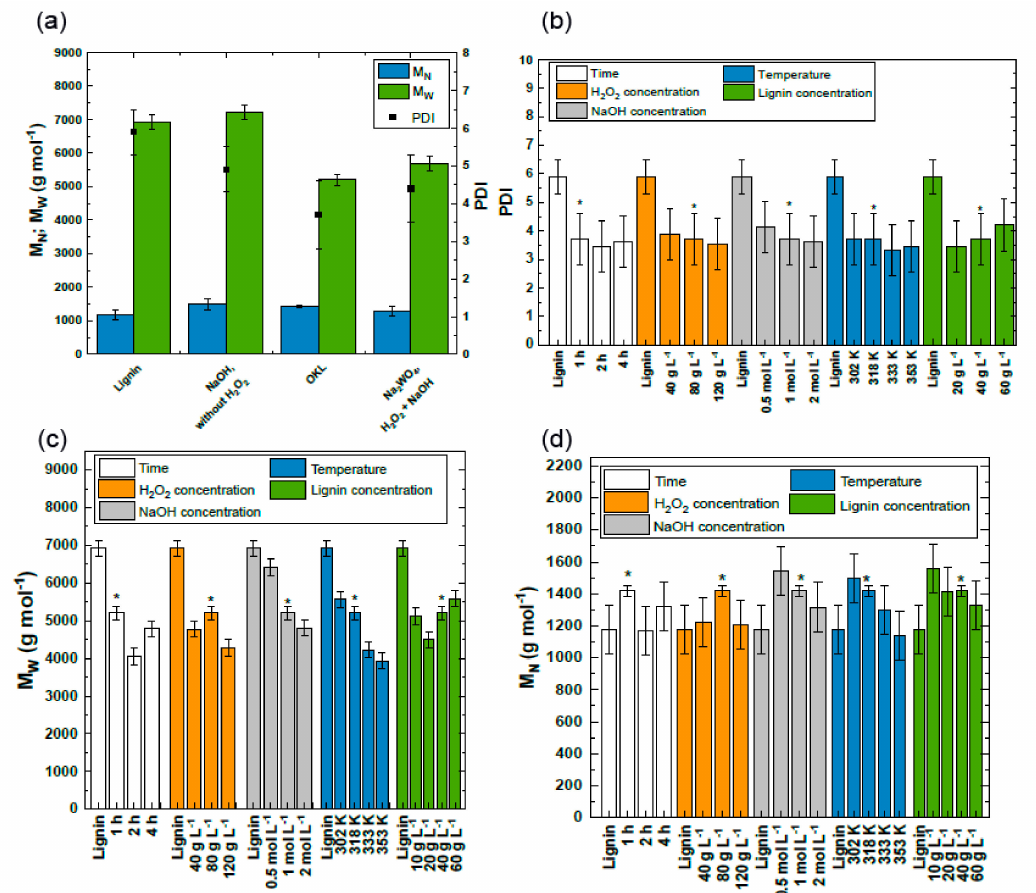
Figure 2. Weightaveragemolecularweight(M W ),numberaveragemolecularweight(M N ),andpolydispersity index (PDI) of lignin, lignin after the blind reaction, OKL, and OKL after application of Na 2 WO 4 as a catalyst ( a ), as well as PDI ( b ), M W , and M N of OKL (( c ) and ( d ), respectively) in dependence on reaction parameters (reaction conditions: c lignin = 40 g L − 1 , c H2O2 = 80 g L − 1 , c NaOH = 1 mol L − 1 , T = 318 K, t = 1 h). In addition, the reference reaction is marked by an asterisk in ( b – d